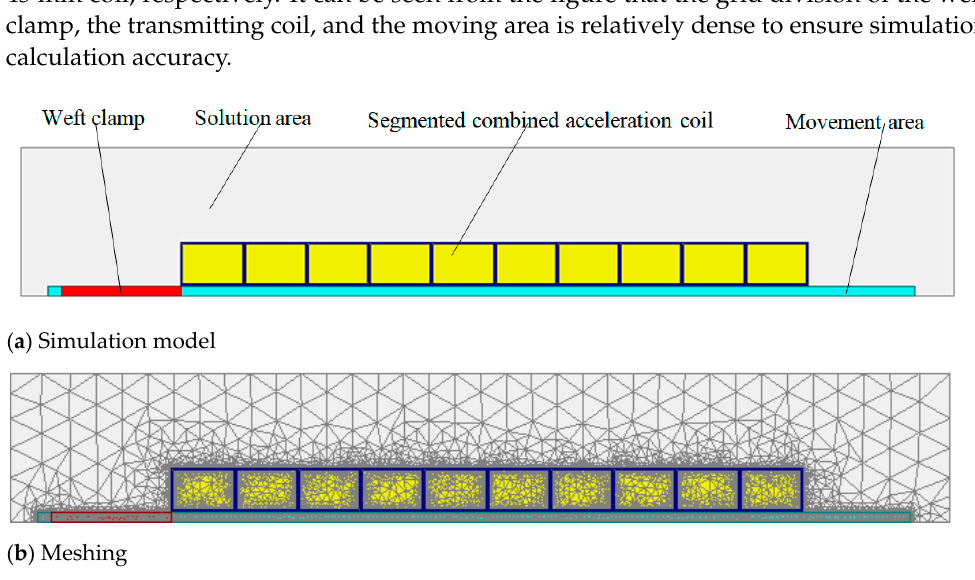
Figure 9. Electromagnetic field simulation of segmented combined 45 mm coil.